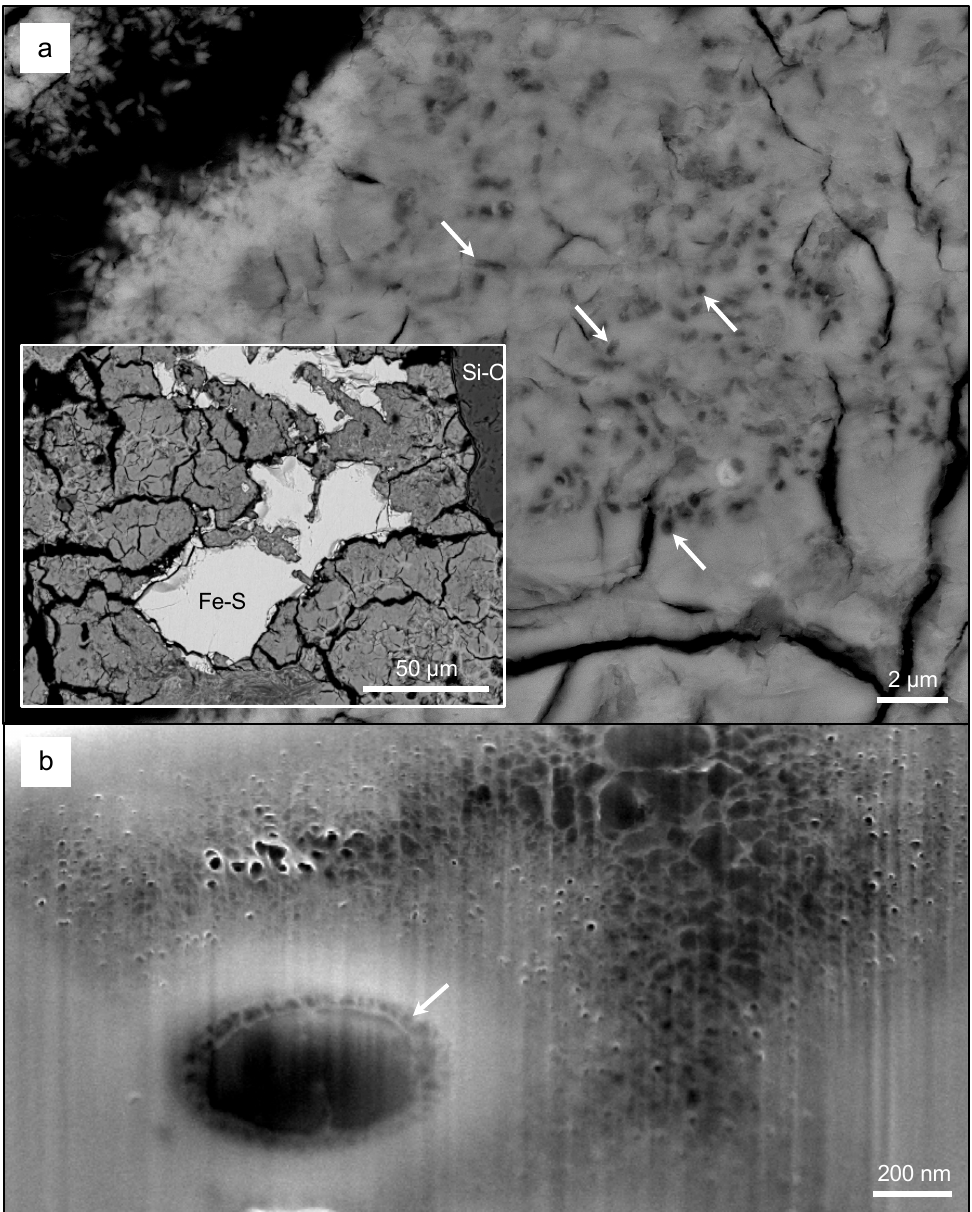
Figure 7. A low-resolution backscatter electron (BSE) SEM micrograph of a weathered metal sulfide and a quartz grain from the lower region ( a , inset). A high-resolution BSE SEM micrograph of schwertmannite/goethite containing clusters of microfossils ( a ). Note that rod-shaped cells produce circular to oval-shaped structures in cross-section ( a , arrows). A high-resolution SE SEM micrograph of the focused ion beam (FIB)-milled section, demonstrating that these microfossils also occurred at depth ( b ). Note the extensive extracellular mineralization of pseudoacicular minerals in comparison to the intercellular space, which has less mineralization (arrow, b ).